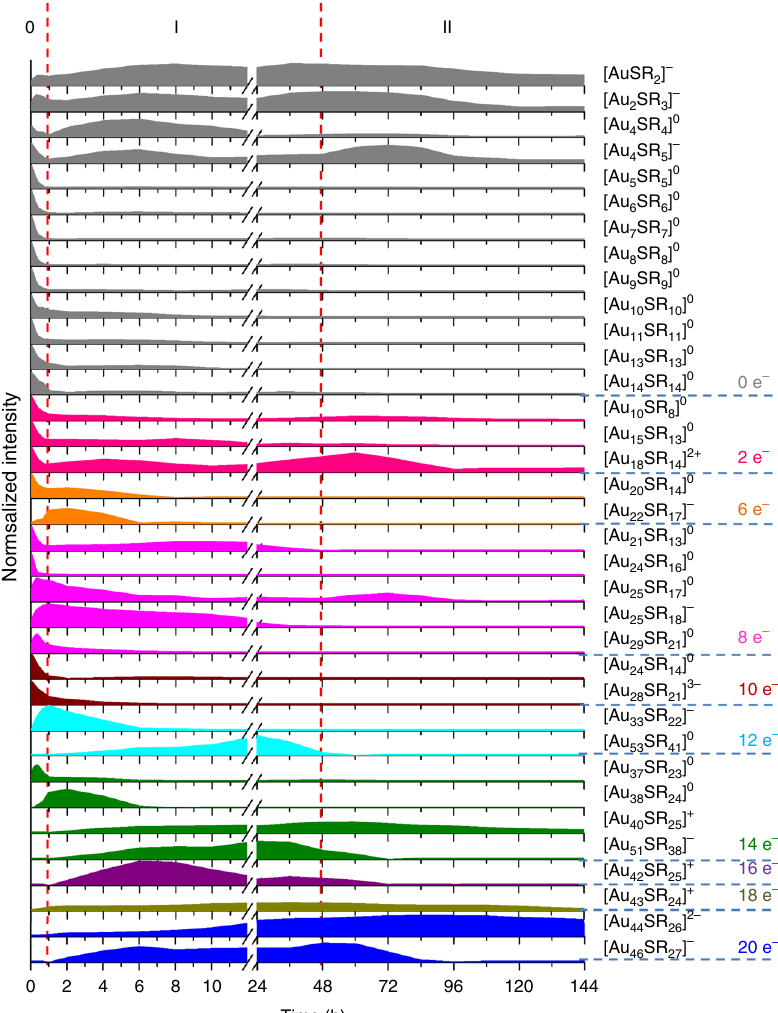
Fig. 4 Time-dependent abundance of the as-identi fi ed Au(I)-SR complex/cluster species. The growth of [Au 44 (SR) 26 ] 2 − can be divided into 3 stages: 0) kinetically dictated accumulation of Au 25 , I) Au 25 -mediated size growth, and II) thermodynamically controlled